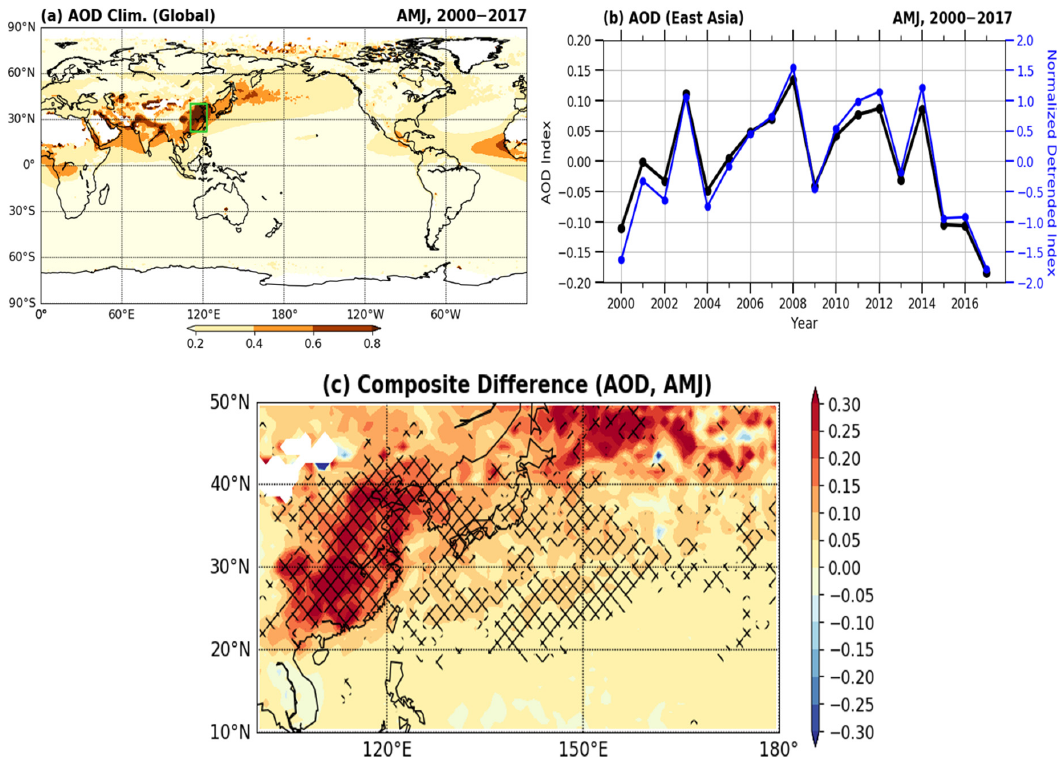
Figure 1. ( a ) Distribution of climatological (2000–2017) aerosol optical depth (AOD). The green box indicates the East Asian region (110.5–122.5° E, 22.5–40.5° N), where AOD is the highest. ( b ) The black line denotes time series data of the AOD index, averaged over the green box area shown in ( a ). The blue line denotes normalized time series data with the linear trend removed from the black line. ( c ) The composite difference of AOD during April–May–June (AMJ; high AOD minus low AOD). Regions with black cross-hatching indicate a statistical significance at a 95% confidence level.